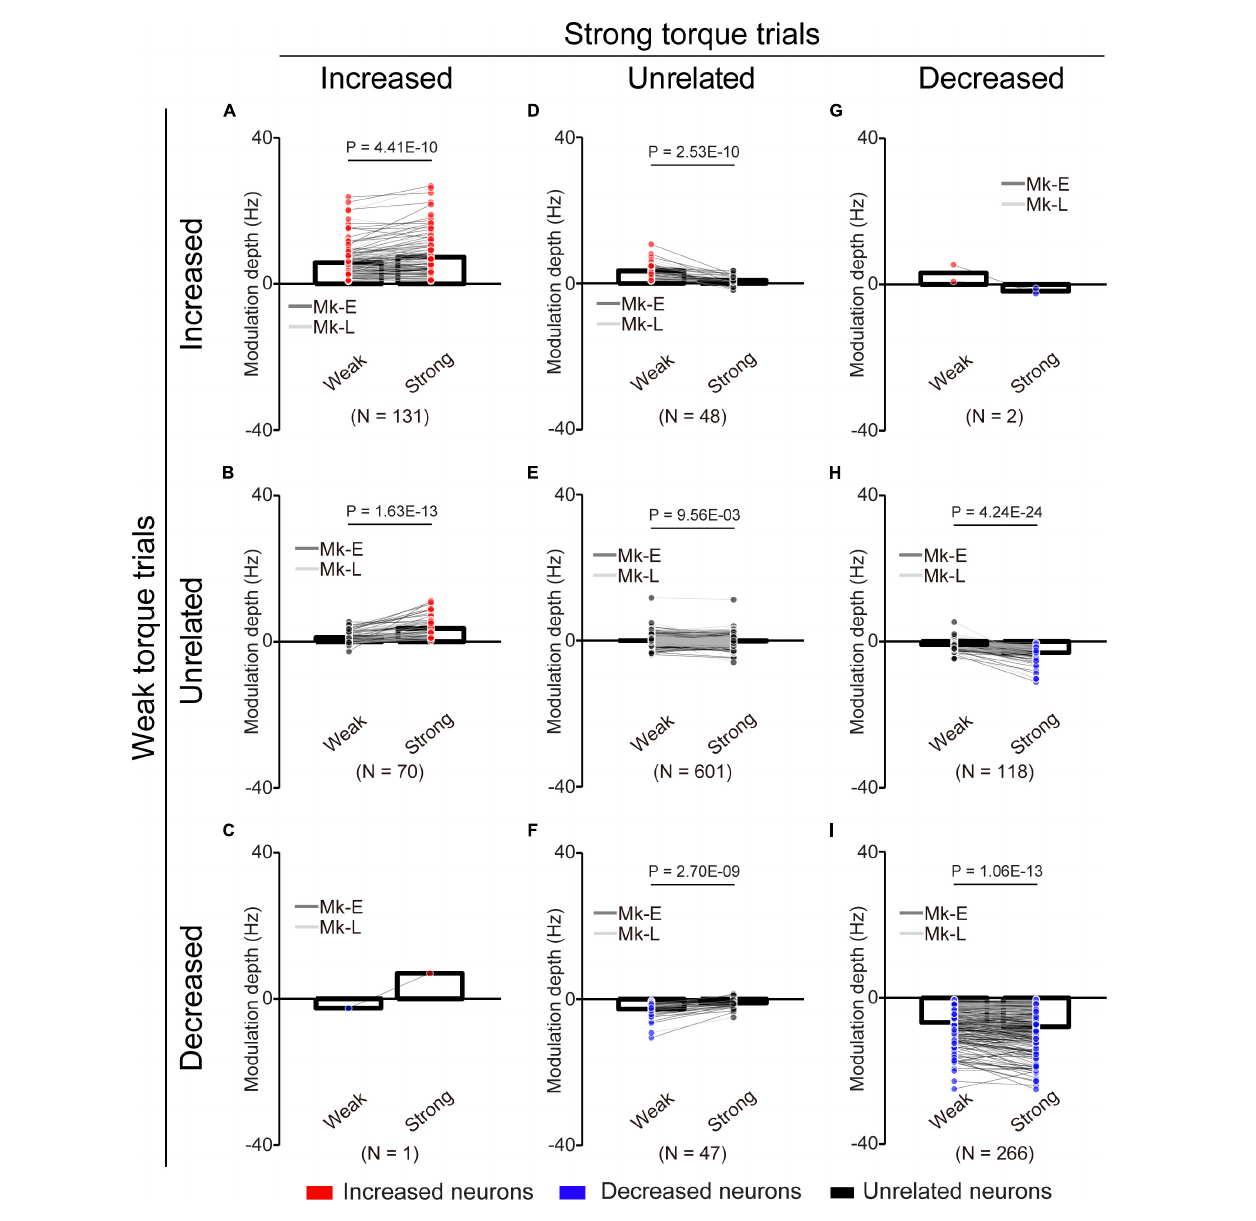
FIGURE8 Change of the MDs of unlinked neurons at different torque requirements. (A) Neurons maintained their properties as “increased” type throughout the experiments. (B) Neurons changed their properties from “unrelated” to “increased” type. (C) Neurons changed their properties from “decreased” to “increased” type. (D) Neurons changed their properties from “increased” to “unrelated” type. (E) Neurons maintained their properties as “unrelated” type. (F) Neurons changed their properties from “decreased” to “unrelated” type. (G) Neurons changed their properties from “increased” to “decreased” type. (H) Neurons changed their properties from “unrelated” to “decreased” type. (I) Neurons maintained their properties as “decreased” type. Bars and circles indicate the MDs of mean values and individual neurons, respectively. Colors (red: increased neuron, black: unrelated neuron, blue: decreased neuron) of the circles represent the neuron types sorted in each condition (i.e., before and during the corticospinal interface and catch trials). Black horizontal lines represent significant differences ( P < 0.05 by paired t -test with Bonferroni’s correction). Experiments with at least nine trials were included in each